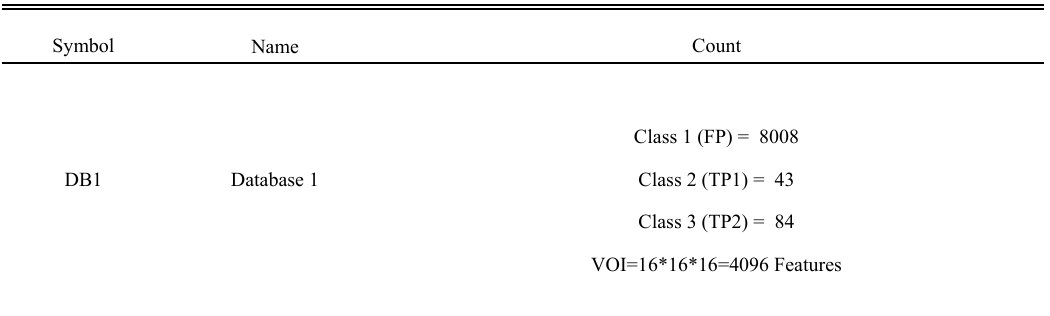
Table 3. Database